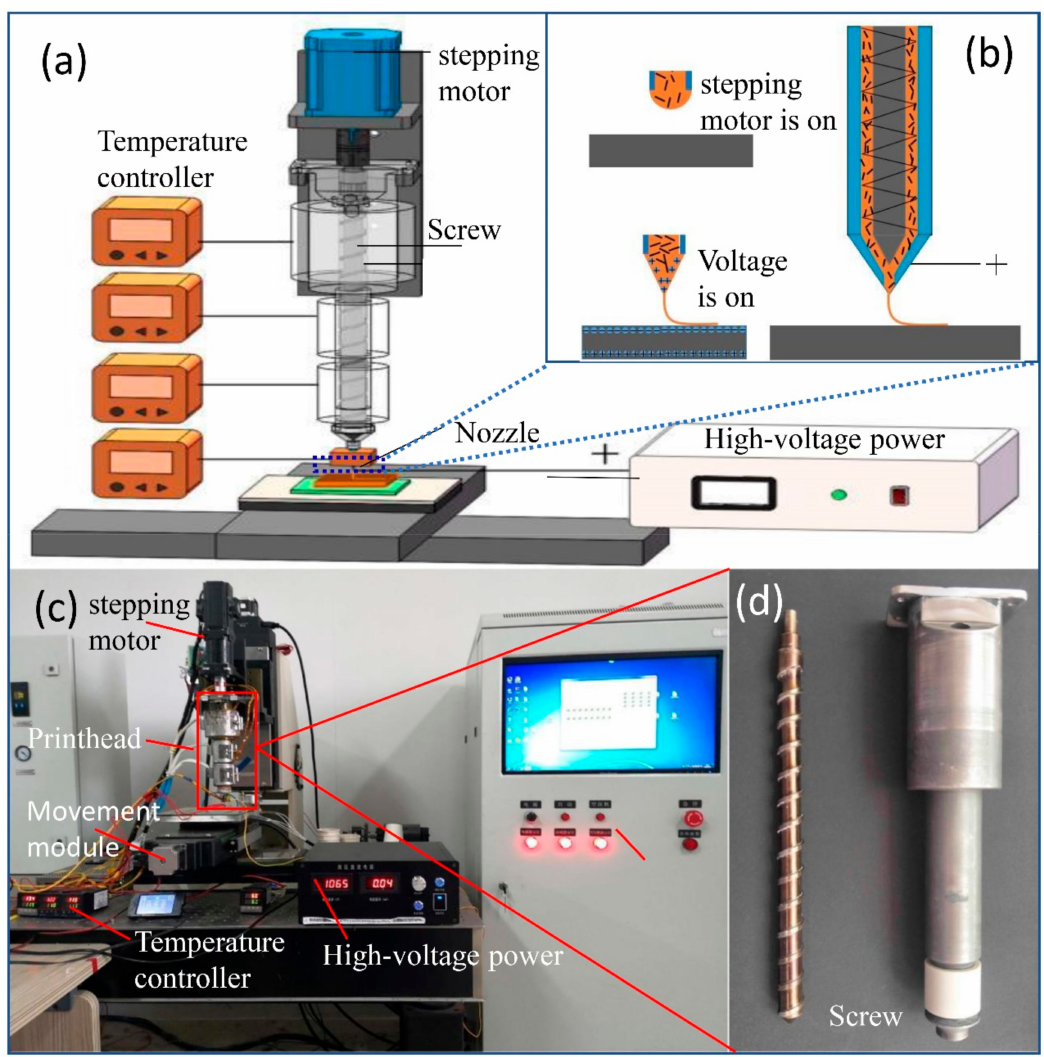
Figure1. Theelectric-field-drivenfusionjetting3Dprintingforpolymermatrixcomposites: ( a )theschematic of the 3D printing system; ( b ) The printing mechanism; ( c ) the 3D printer; ( d ) the